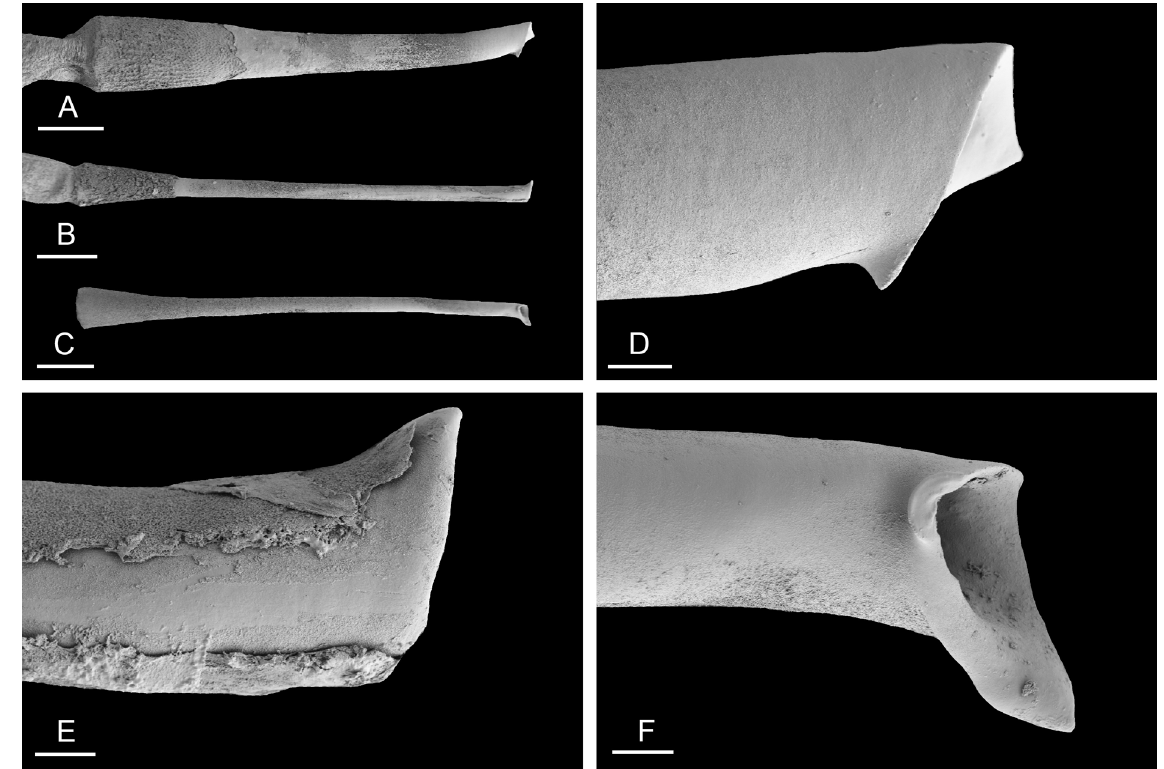
Fig. 19. Paromoionchis tumidus (Semper, 1880) comb. nov. unit #2, spine of accessory penial gland. A . Australia, Northern Territory [1638] (NTM P.57623). B . Philippines, Luzon [3237] (PNM 041265). C . Philippines, Luzon [3172] (PNM 041262). D . Distal tip of spine, same as A. E . Distal tip of spine, same as B. F . Distal tip of spine, same as C. Scales: A = 150 μm; B–C = 200 μm; D–F = 20 μm.